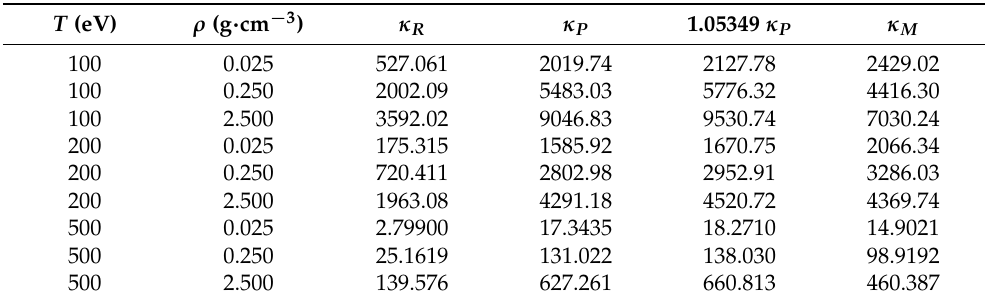
cm − 3 ). The value of Armstrong’s bound (1.05349 · g − 1 . ·